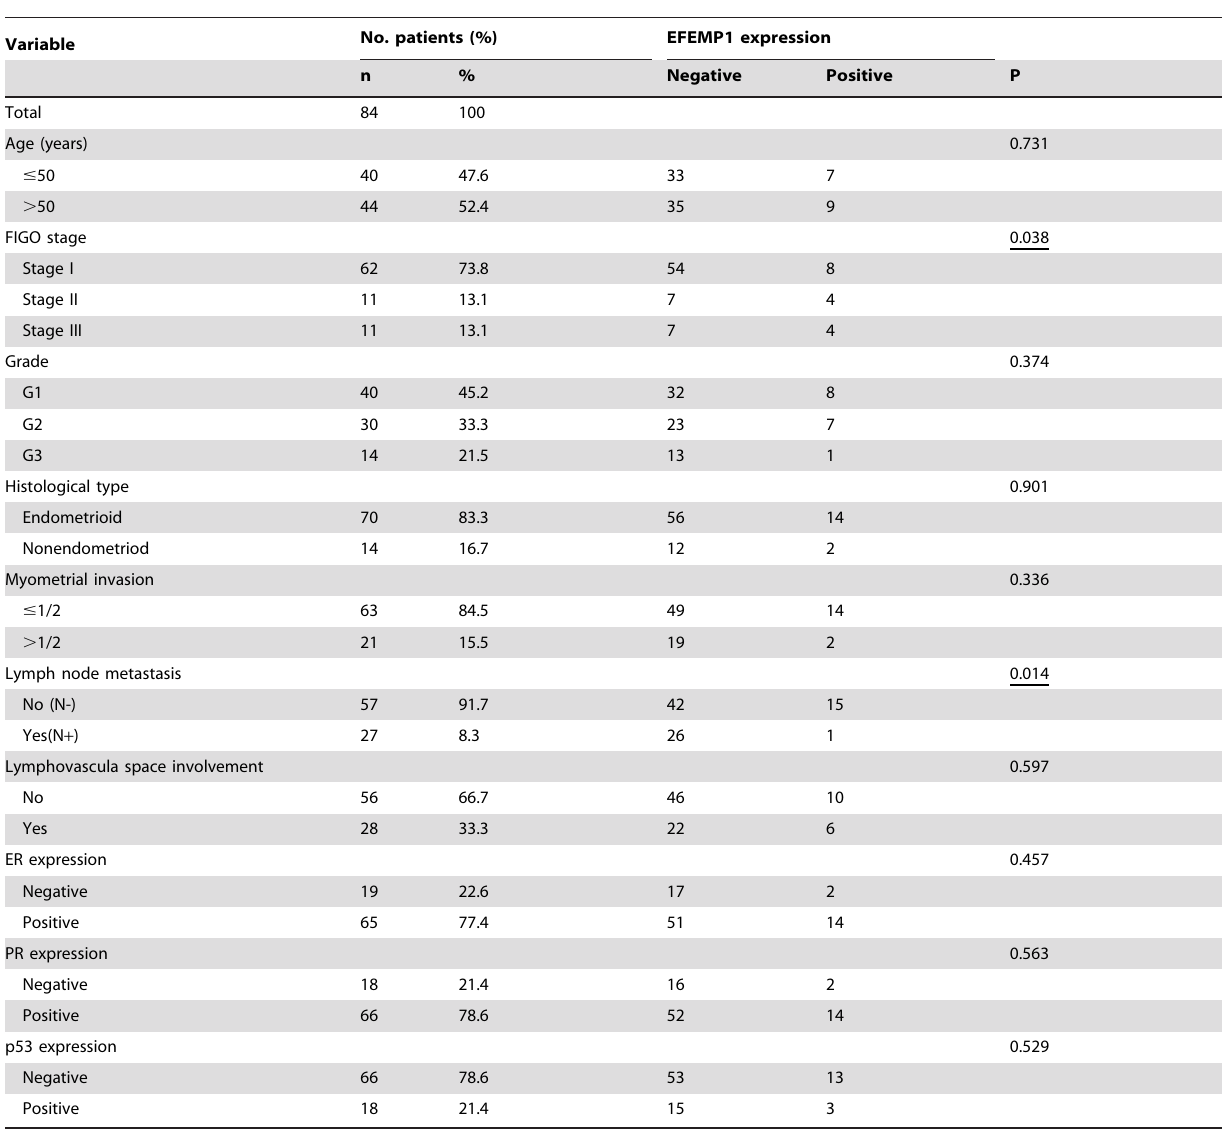
Table 2. Immunohistochemical expression of EFEMP and its association with clinic-pathological variables.